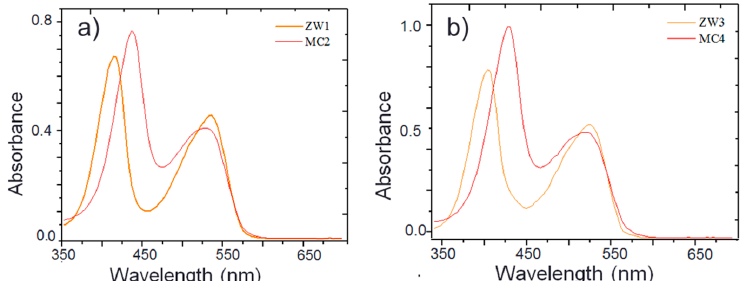
Figure 1. ( a ) Absorption spectra of ZW1 in acetonitrile and its corresponding deprotonated MC2 compound (c = 3.85 × 10 − 5 M); ( b ) Absorption spectra of ZW3 in acetonitrile and its corresponding deprotonated MC4 compound c = 7.69 × 10 − 5 M).